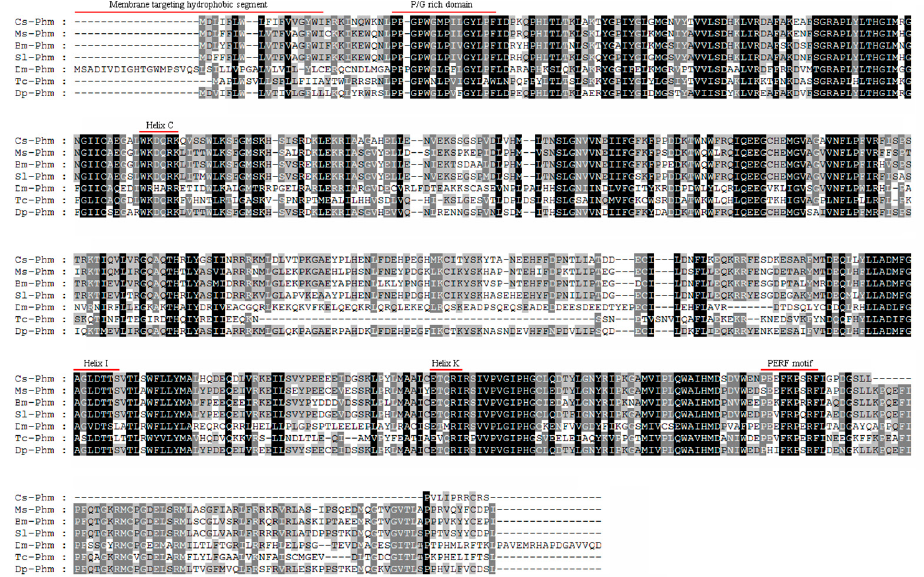
Figure 2. Alignment of CYP306A1 sequences originating from C. suppressalis (KF701127), Ms— Manduca sexta (ABC96068), Bm— Bombyx mori (BAM73853), Sl— Spodoptera littoralis (ACM45975), Dm— Drosophila melanogaster (NP573319), Tc— Tribolium castaneum (XP968477) and Dp— Danaus plexippus (EHJ76071). Amino acids shaded in black, dark grey, and light grey demonstrated 100%, >80%, and >60% conservation, respectively.